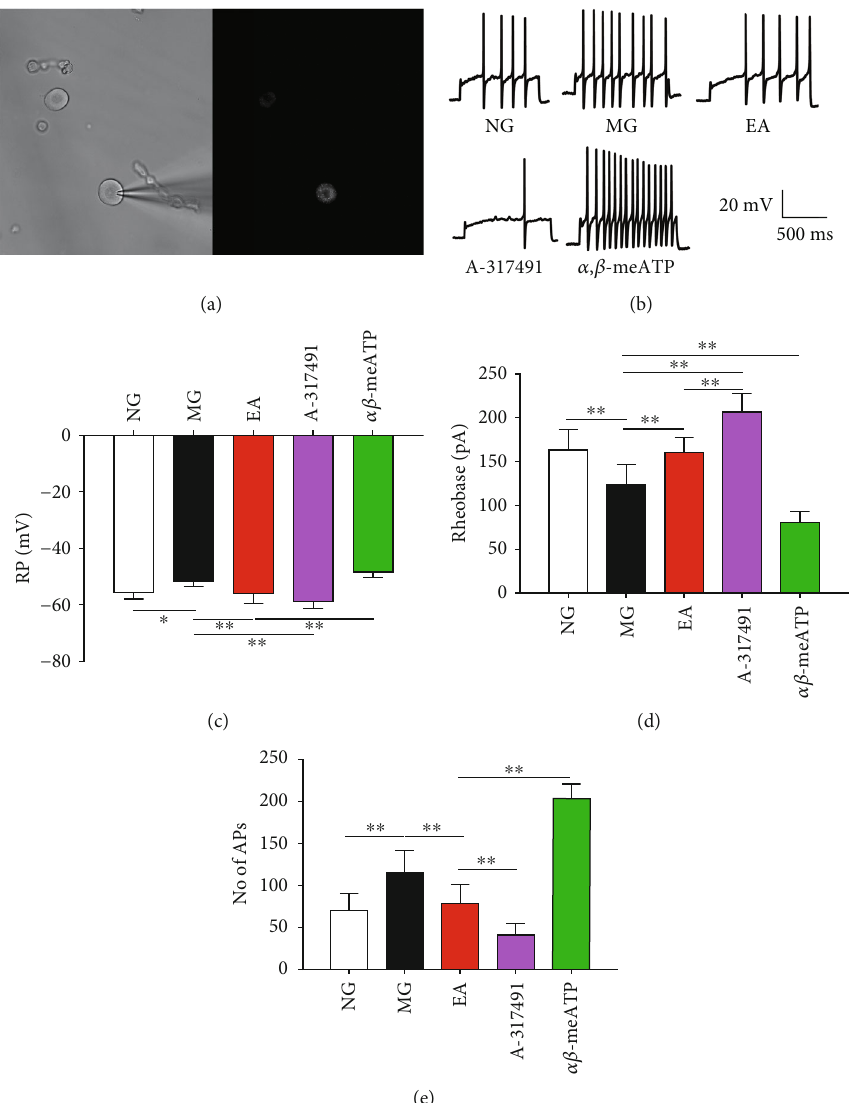
Figure 4: Changes in the membrane electrical properties of the colon-associated DRG neurons. (a) The left fi gure shows di ff erential interference contrast (DIC) imaging of DRG neurons after digestion, and the right fi gure shows fl uorescence imaging of colon-associated neurons labeled with DiI. (b) Representative traces of APs after a 200pA depolarization current injection into DiI-labeled neurons. (c) Changes in the cell RMP in colon-related DRG neurons. (d) Changes in the rheobase in colon-related DRG neurons. (e) Number of APs of neuronal cells in colon-related DRG. ∗ P < 0 : 05 , ∗∗ P < 0 : 01